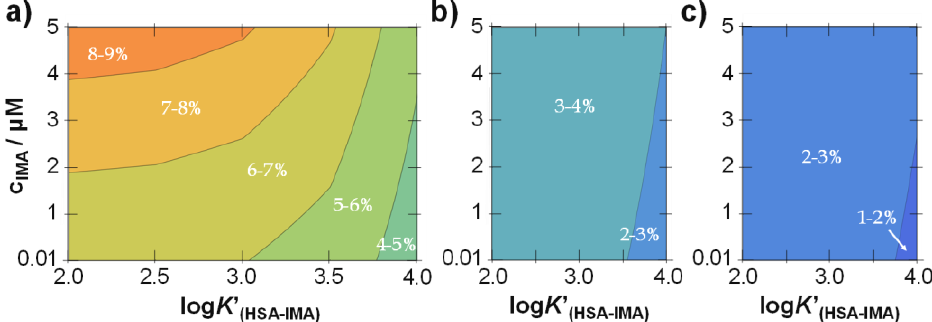
Figure 13. Model calculations on the free fraction (%) of IMA in blood serum by variation of the total concentration of IMA (0.01 – 5 μM), the HSA -IMA stability constant and the total concentration of ( a ) AGP: 15 μM, ( b ) 30 μM or ( c ) 45 μM [log K’ (AGP-IMA) = 6.0].